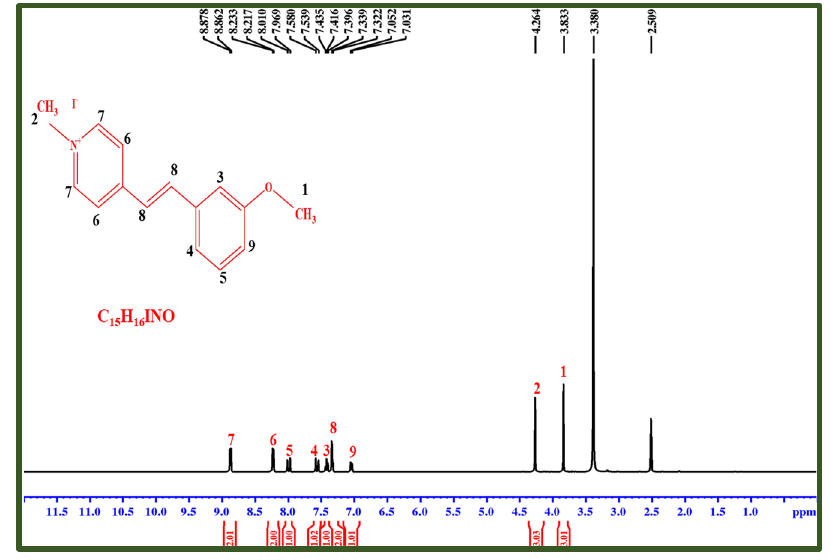
Figure 6. 1 H Nuclear magnetic resonance for MMPI crystal.